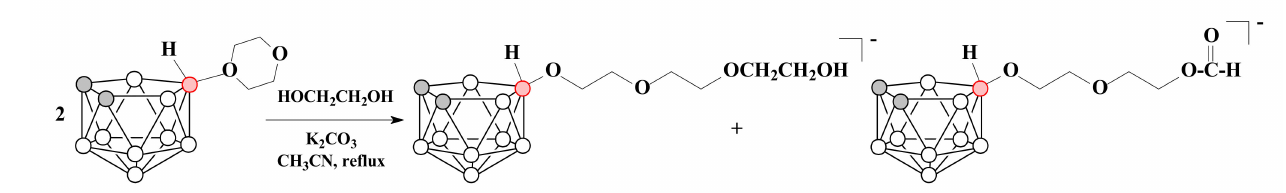
Scheme 9. The reaction of 1,4-dioxane derivative of nido -carborane with ethylene glycol. The reaction of a 1,4-dioxane derivative of nido -carborane with thiourea leads to the formation of a thiouronium salt 10-(NH 2 ) 2 CSCH 2 CH 2 OCH 2 CH 2 O-7,8-C 2 B 9 H 11 , the subsequent hydrolysis of which gives the corresponding thiol [10-HSCH 2 CH 2 OCH 2 CH 2 O- 7,8-C 2 B 9 H 11 ] − . The formed thiol was reacted with one equivalent of 1,4-dioxane derivative of nido -carborane to give a podand [(10-CH 2 CH 2 OCH 2 CH 2 O-7,8-C 2 B 9 H 11 ) 2 S] 2 − related to acyclic crown ether 15-crown-5 [79] (Scheme 10).